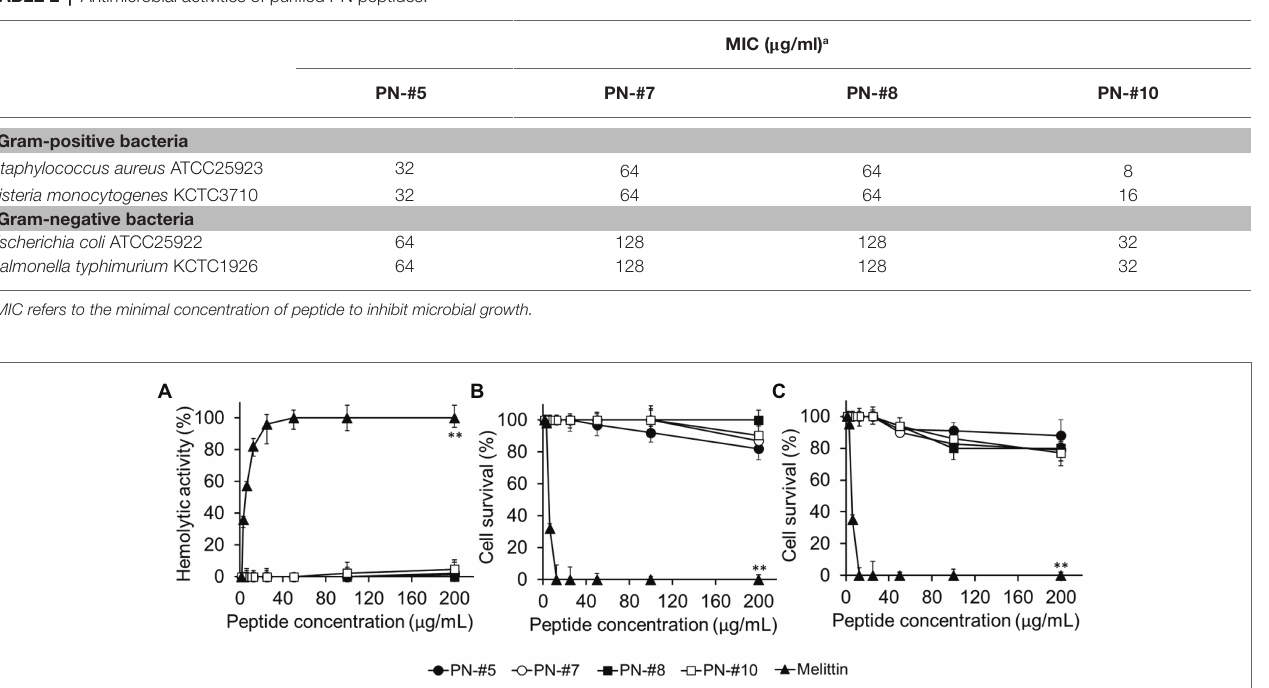
FIGURE 5 | Hemolysis in mRBCs and cytotoxicity against RAW264.7 murine macrophages and HaCaT human keratinocyte cells. Hemolytic activity against mRBCs ( n = 3 per condition) (A) . Cytotoxic activity against RAW264.7 ( n = 4 per condition) (B) ; and HaCaT ( n = 3 per condition) (C) cells. Statistical analysis was performed by one-way ANOVA. ** p < 0.01 vs.